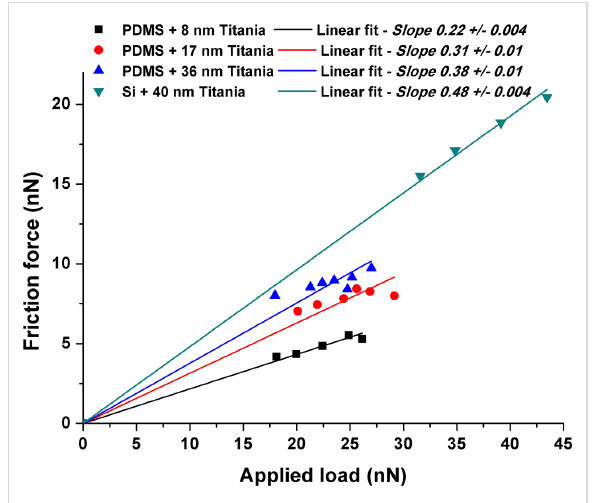
Figure 9: Applied load vs friction force curves and µ evaluated by lateral force microscopy.